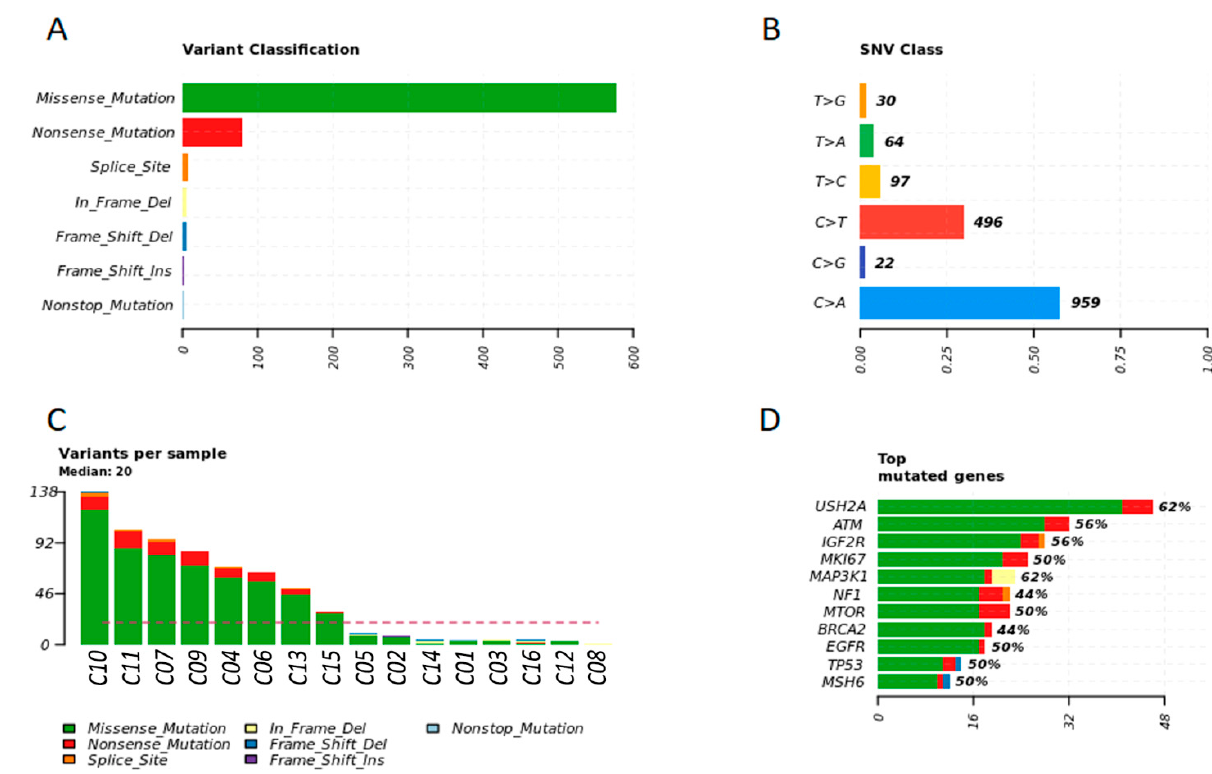
Figure 2. Genetic variation in tumor fragments of women with BC. ( A ) Representative variant classification. ( B ) Single-nucleotide variant (SNV) classification. ( C ) Representative variants per fragment sample. ( D ) Top mutated genes showing multiple variant mutations. Graphics were generated in the R language, using the Maftools package.